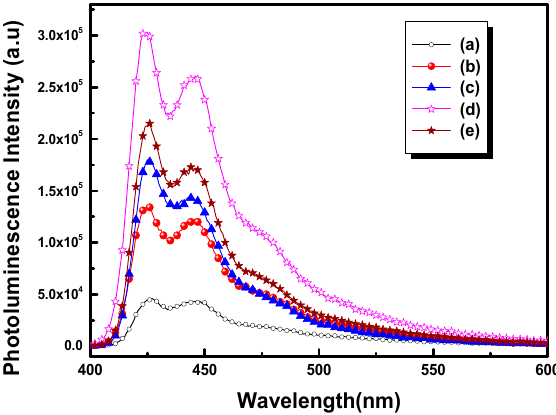
Figure 7. Photoluminescence spectra of POF 10 – b– PDPAEMA 90 in water at different pH levels: ( a ) 2, ( b ) 5, ( c ) 7, ( d ) 9, ( e ) 11.